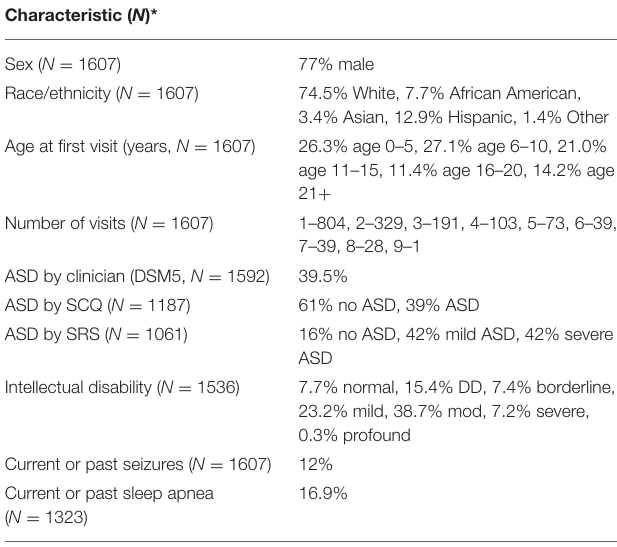
TABLE 1 | Demographics of the FORWARD cohort.